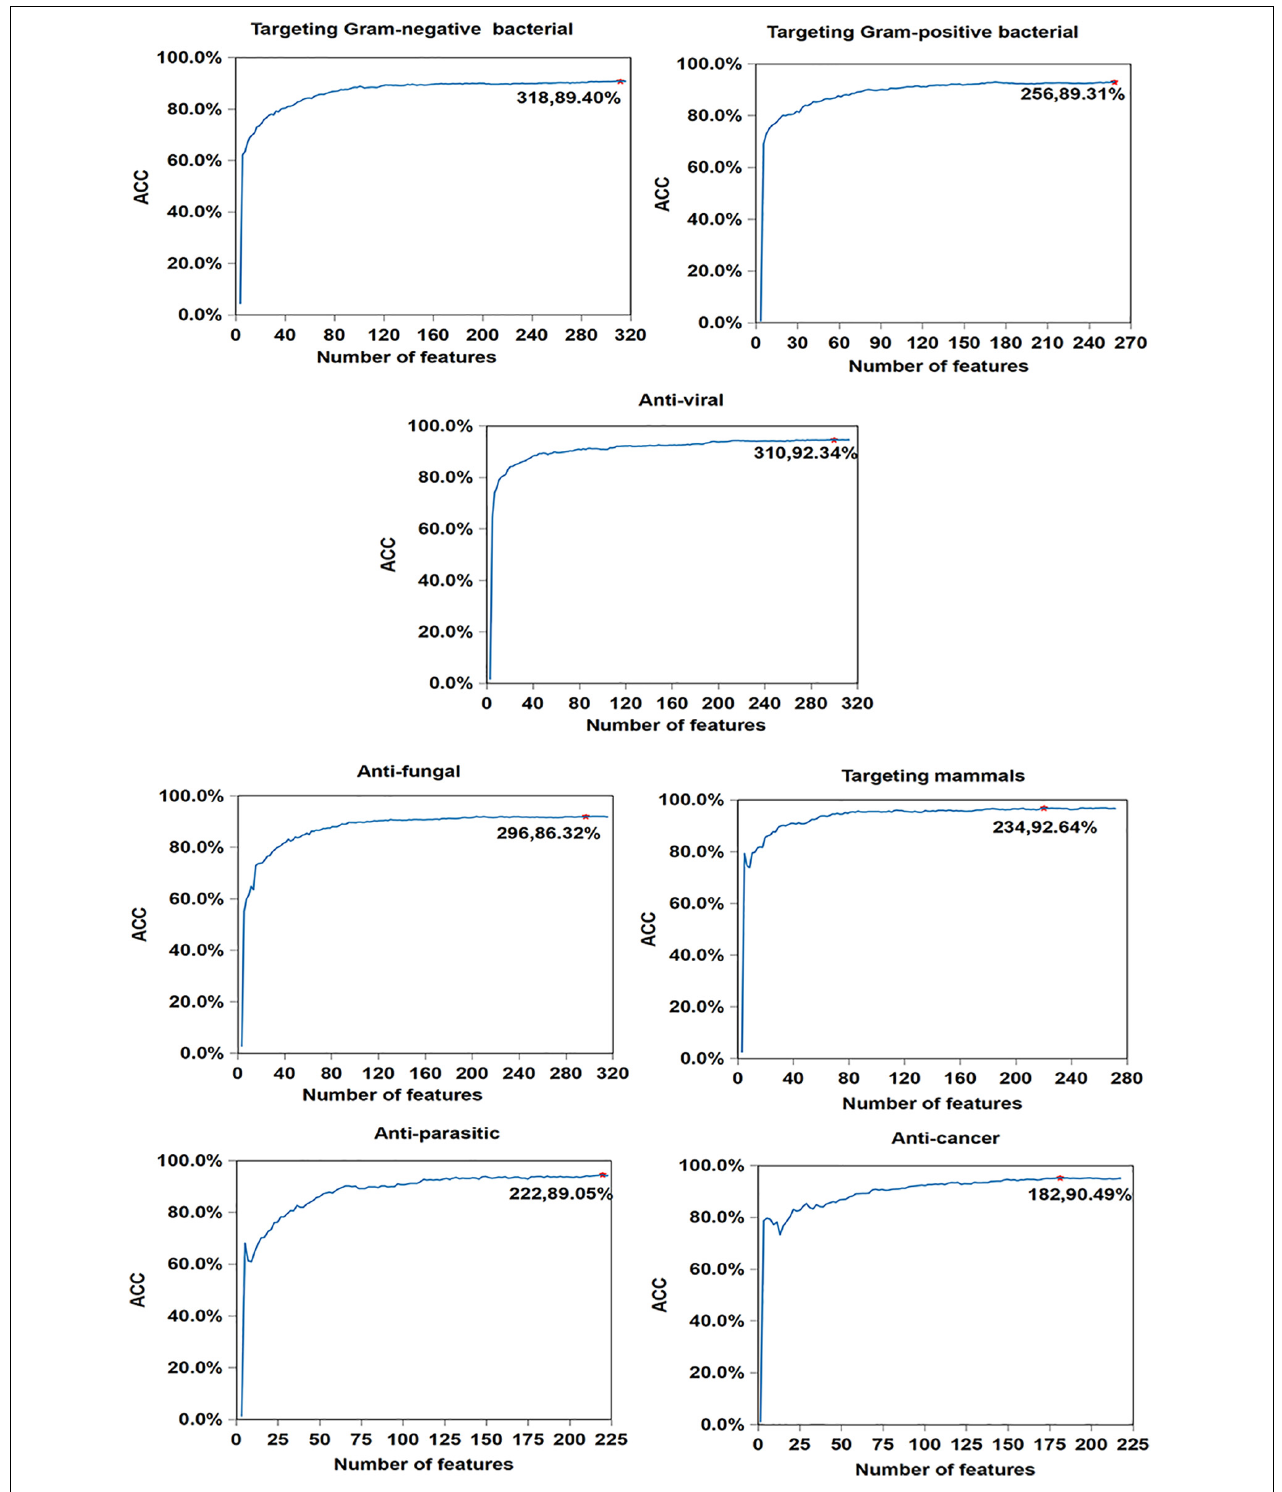
FIGURE 4 | Result of feature selections for seven AMP functional activities. The horizontal axis represents the number of features, and the vertical axis represents the value of ACC. The number of selected features and the value of corresponding ACC are marked on the curve.